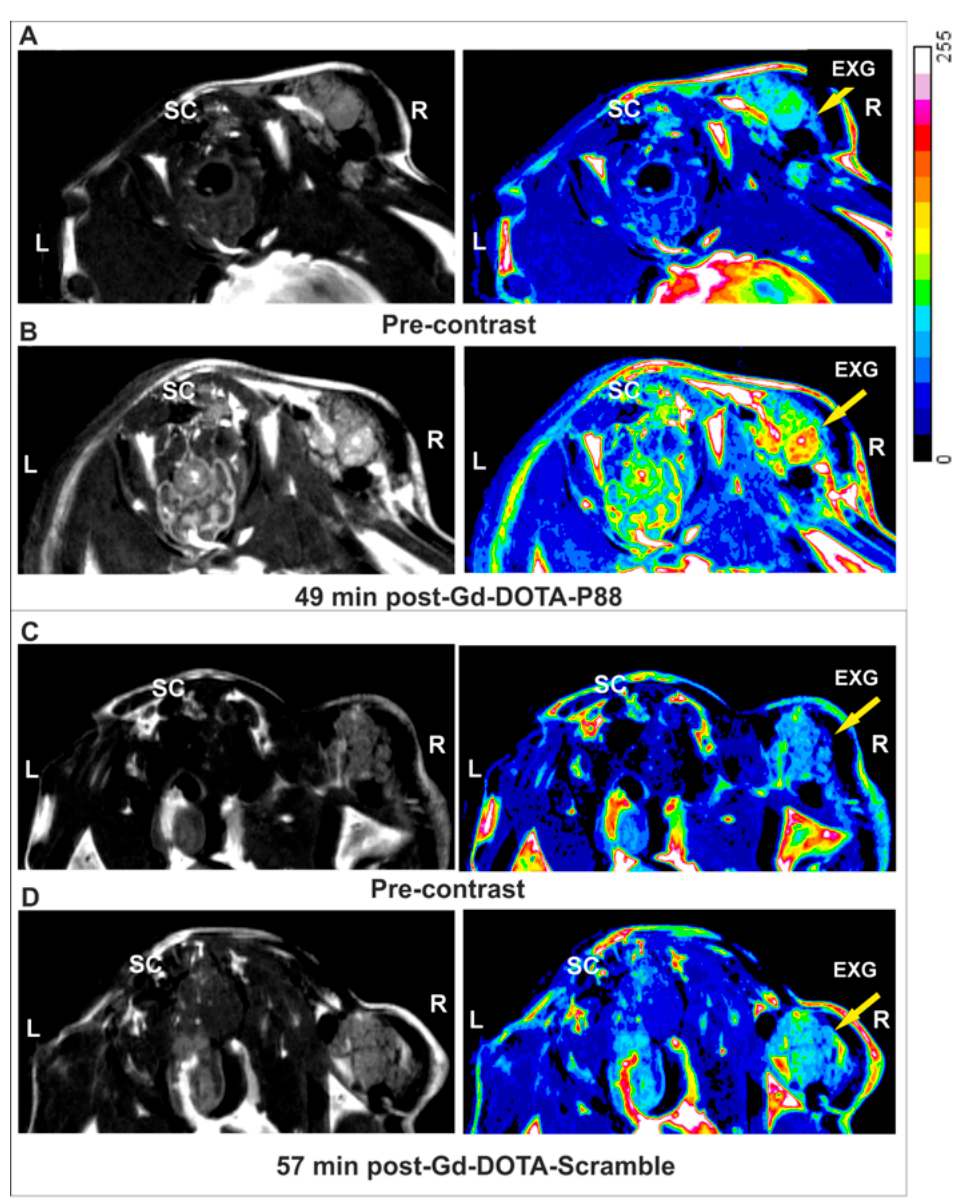
Figure S5 ( D – I ). Histological evaluation of the implanted EndoC- β H1 tumors, showing cells clustered into pseudo-islets surrounded by fibrotic tissue ( D ), capillary networks (yellow arrows) ( E ), insulin expression ( F ) with its corresponding negative control ( G ) and FXYD2 γ a detected with either SPY393 polyclonal antibody ( H ) or the biotinylated P88 ( I ); ( D – I ) are representative micrographs from 2 EndoC- β H1 cell-implanted mice.